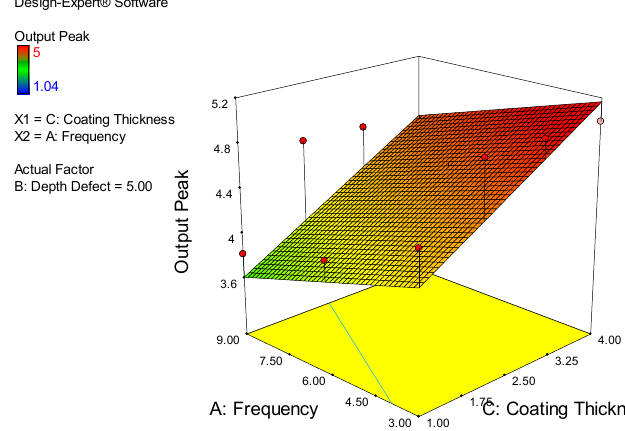
Figure 20. Relations between Frequency, Coating Thickness and Output Peak.